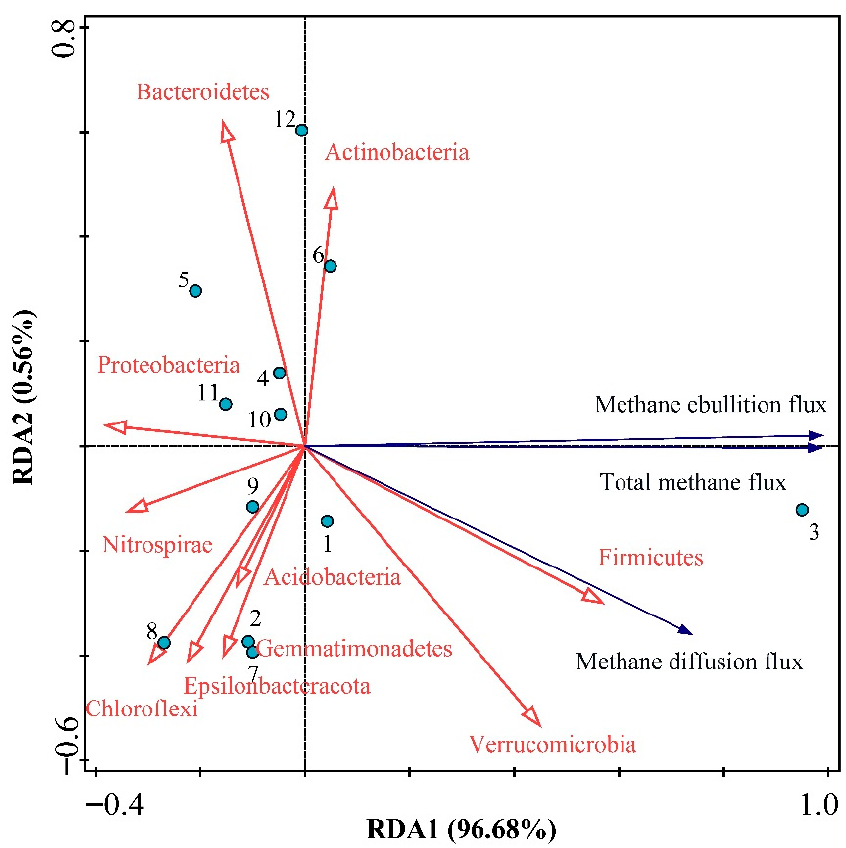
Figure 6. Redundancy analysis of the correlation between CH 4 fluxes and abundance of sediment microbes. Red arrows represent sediment microbial communities, black arrows indicate CH 4 fluxes, and blue dots represent sampling points (1–12).